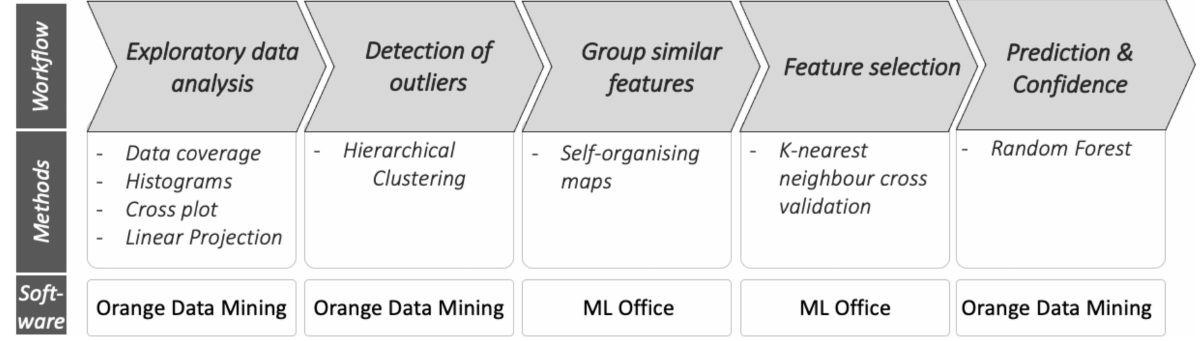
Figure 3. Workflow, methods and software used in this study. Software used included Orange Data Mining [27] and Machine Learning (ML) Office [30].